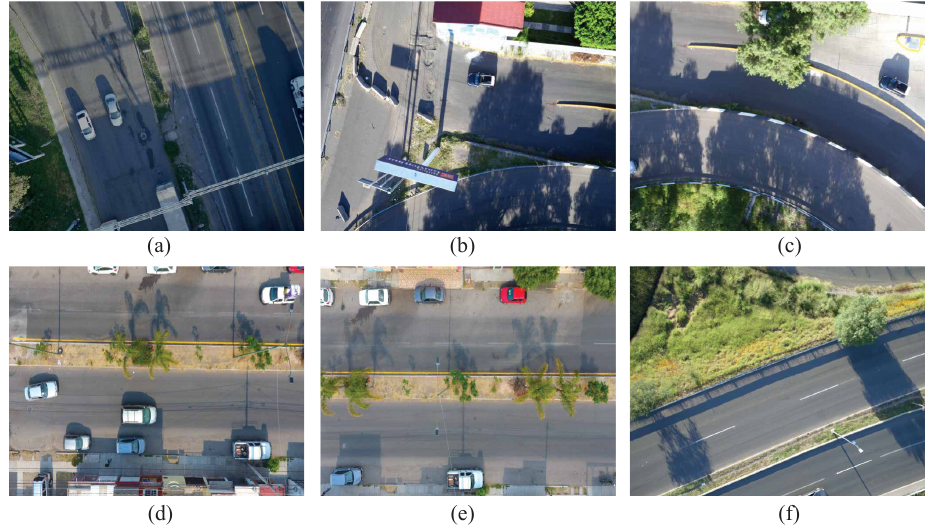
Figure 5. Test images, urban scenes covered by about 40–60% of shadows: study cases 1 ( a ), 2 ( b ), and 3 ( c ). The second group of urban scenes covered by about 20–25% of shadows: study cases 4 ( d ), 5 ( e ), and 6 ( f